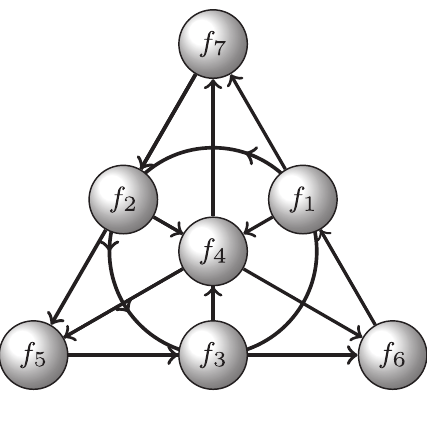
Figure 3. Diagram of Fano for